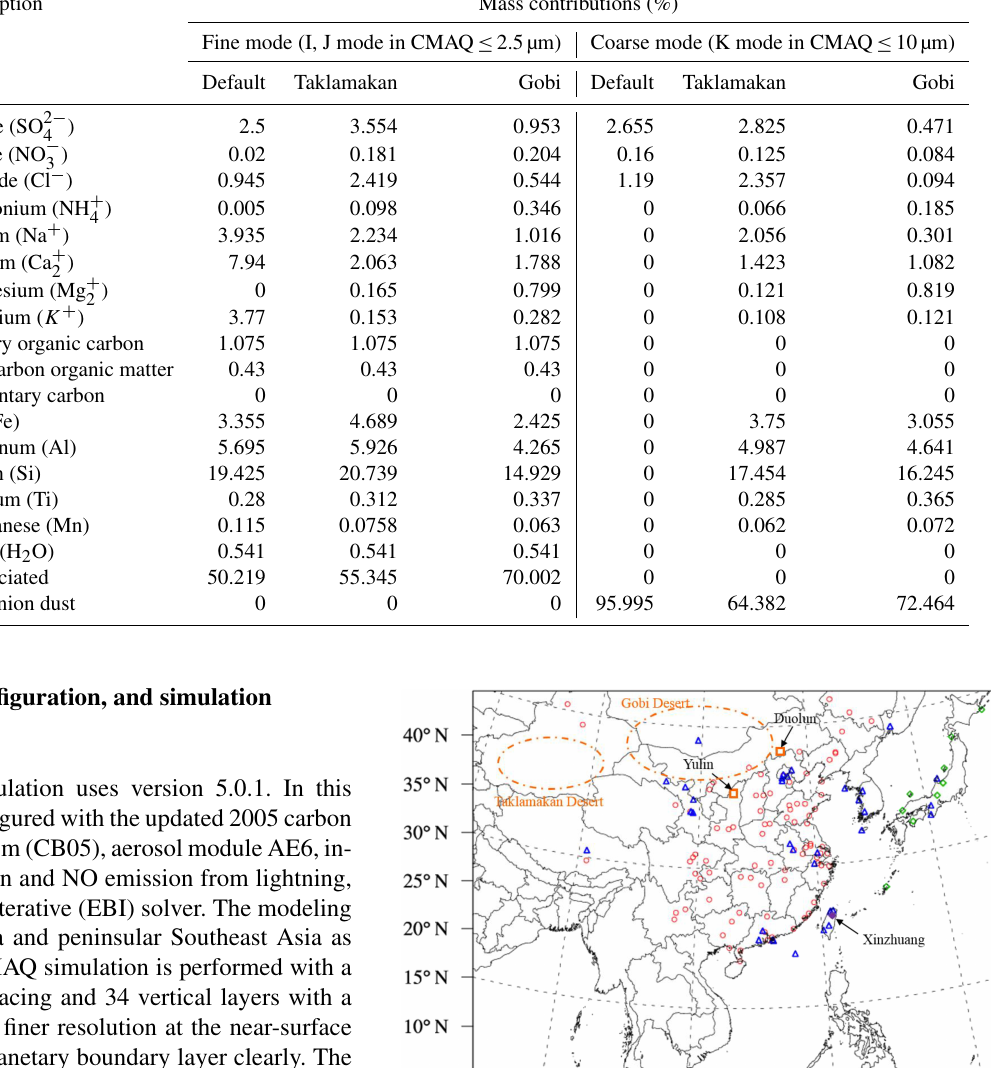
Table 2. Dust emission speciation profiles from the default CMAQ, and the profiles derived in this study for the Taklamakan and Gobi deserts. Model species